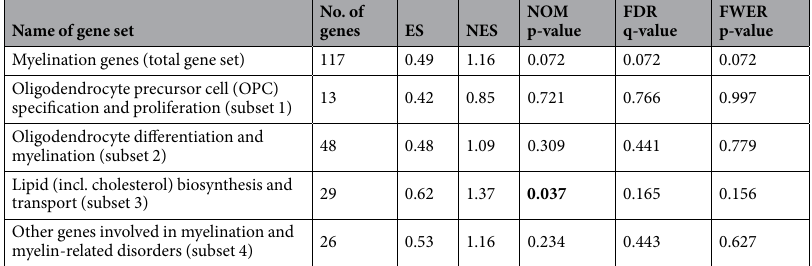
Table 1. Gene set enrichment analysis (GSEA) for myelin gene sets. The GSEA performs running sum statistics and calculates an enrichment score for each of the selected myelin-related genes, considering their rank in the pre-ranked gene list from the SCZ GWAS. The significance of the score was calculated using 1,500 permutations of the ranked list. Abbreviations: ES – enrichment score; NES – normalized enrichment score; NOM – nominal p-value; FDR – false discovery rate; FWER – family-wise error